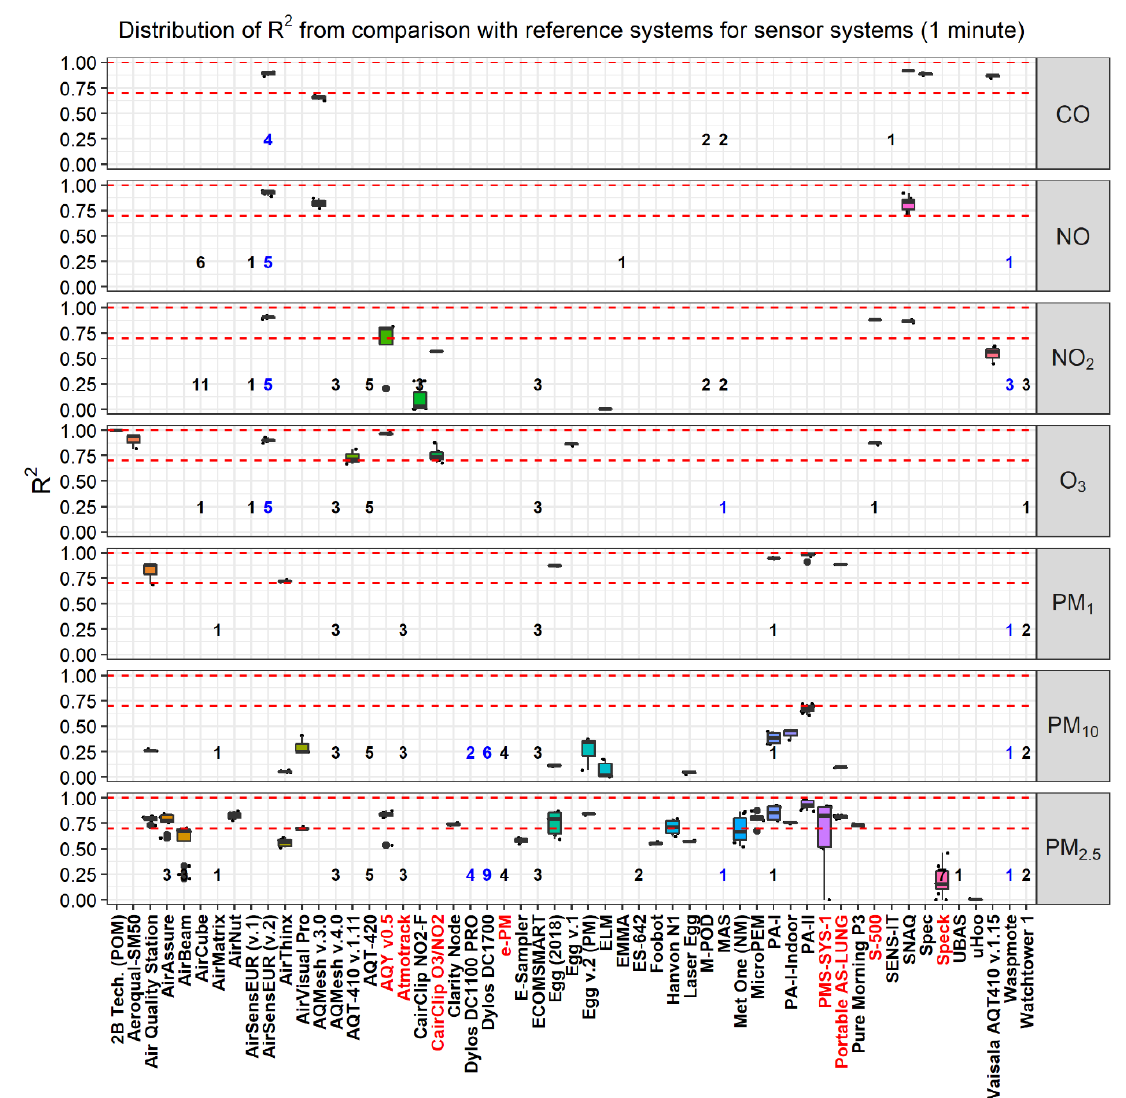
Figure A3. Distribution of R 2 from the comparison of SSys minute data against reference measurements. Numbers in blue and black indicate the number of open source and black box records, respectively. Names of “living” and “non-living” sensors are indicated by black and red labels on the x-axis, respectively.